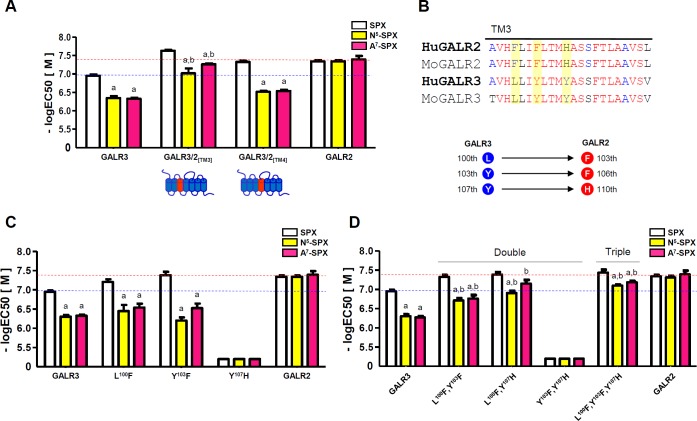
Determination of the core regions in GALR2 that interact with the Asn5 and Ala7 residues of the ligand.(A) The TM3 and TM4 domains of GALR3 were replaced with the corresponding domains of GALR2. The responses of the mutant receptors to SPX, [N5]-SPX, and [A7]-SPX were then tested. (B) Amino acid sequence comparison of the TM3 domains from human (Hu) and mouse (Mo) GALR2 and GALR3. (C) The responses of the single-mutant (Leu100Phe, Tyr103Phe, or Tyr107His) GALR3 proteins to SPX, [N5]-SPX, and [A7]-SPX. (D) The responses of the double-mutant and triple-mutant GALR3 proteins to SPX, [N5]-SPX, and [A7]-SPX. The horizontal red and blue dashed lines represent the responses of GALR2 and GALR3, respectively, to SPX. The EC50 values are presented as the mean ± SE (a: P < 0.05 vs. SPX; b: P < 0.05 vs. WT GALR3).